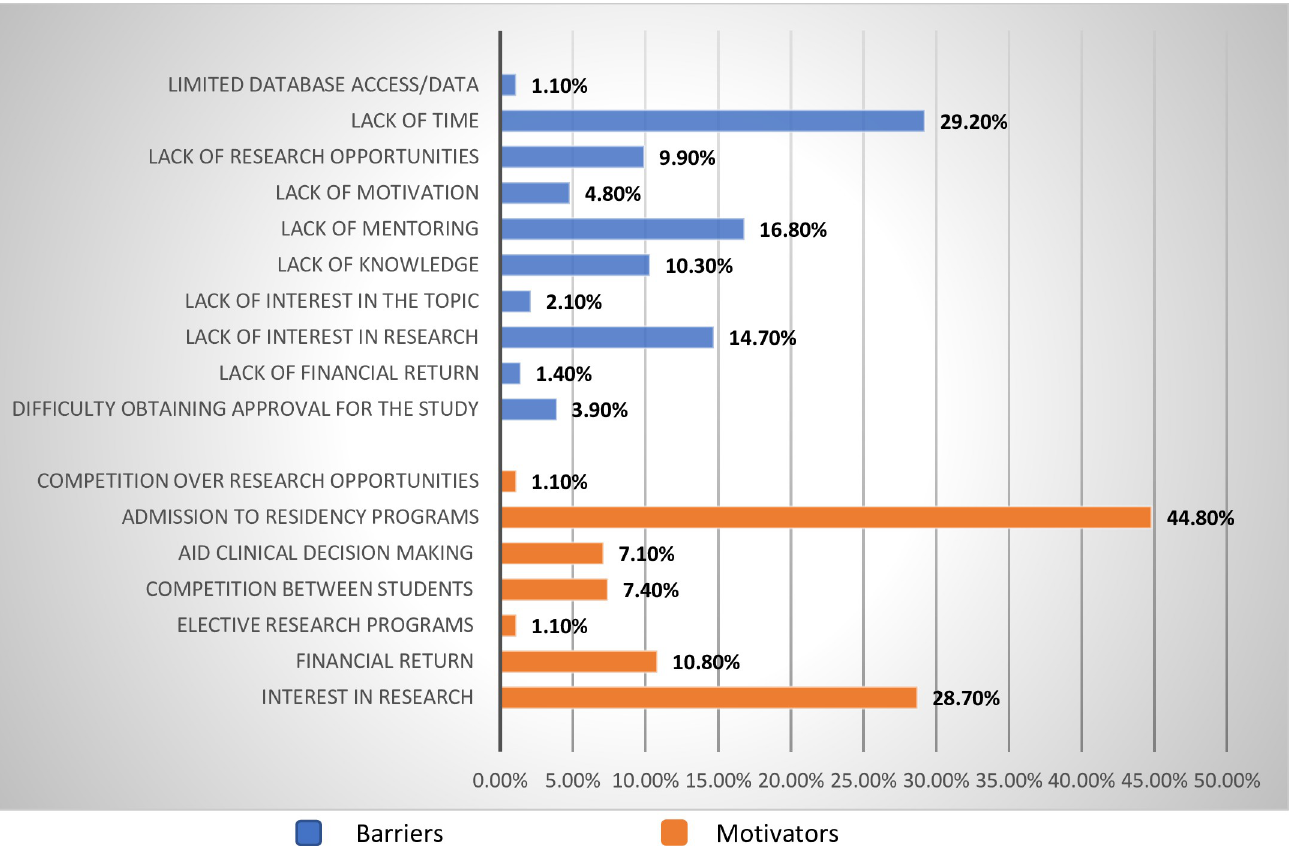
Fig 2. Reported factors that influence the conduct of